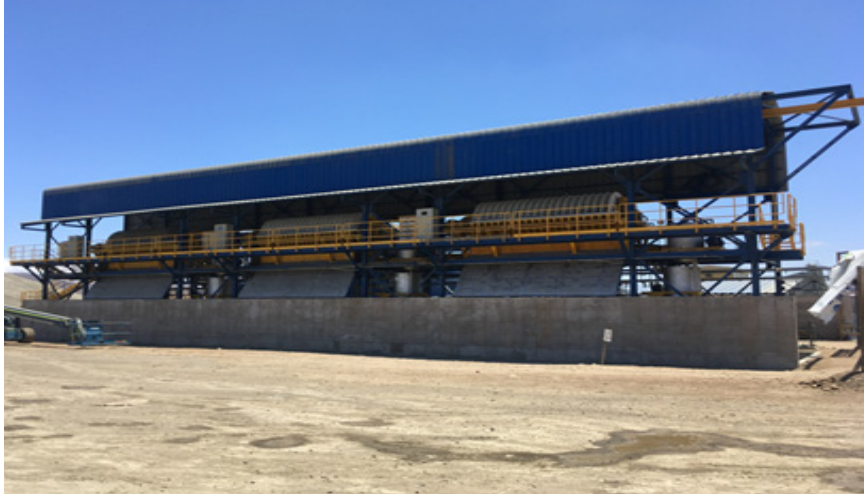
Figure 44. Tambillos Tailings Ceramic Disc Filters [48,66].